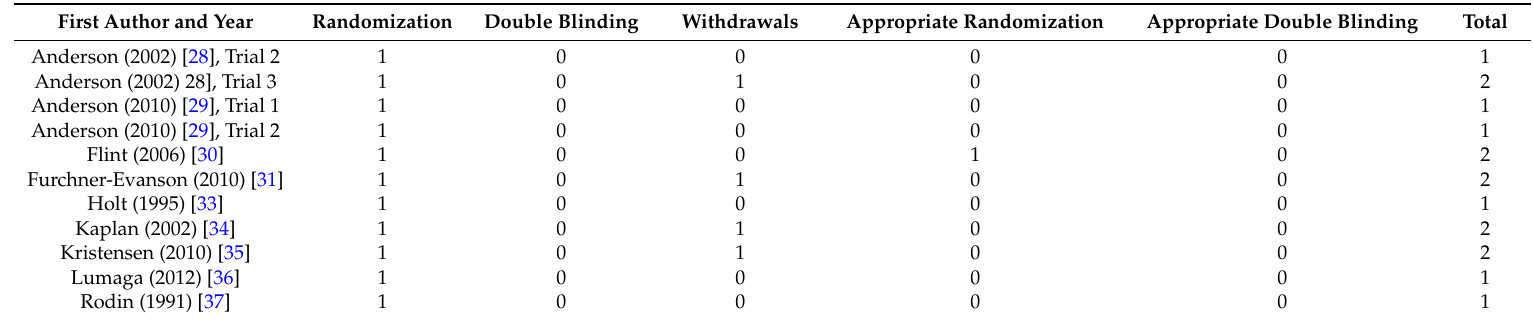
Table 2. Methodological quality of included